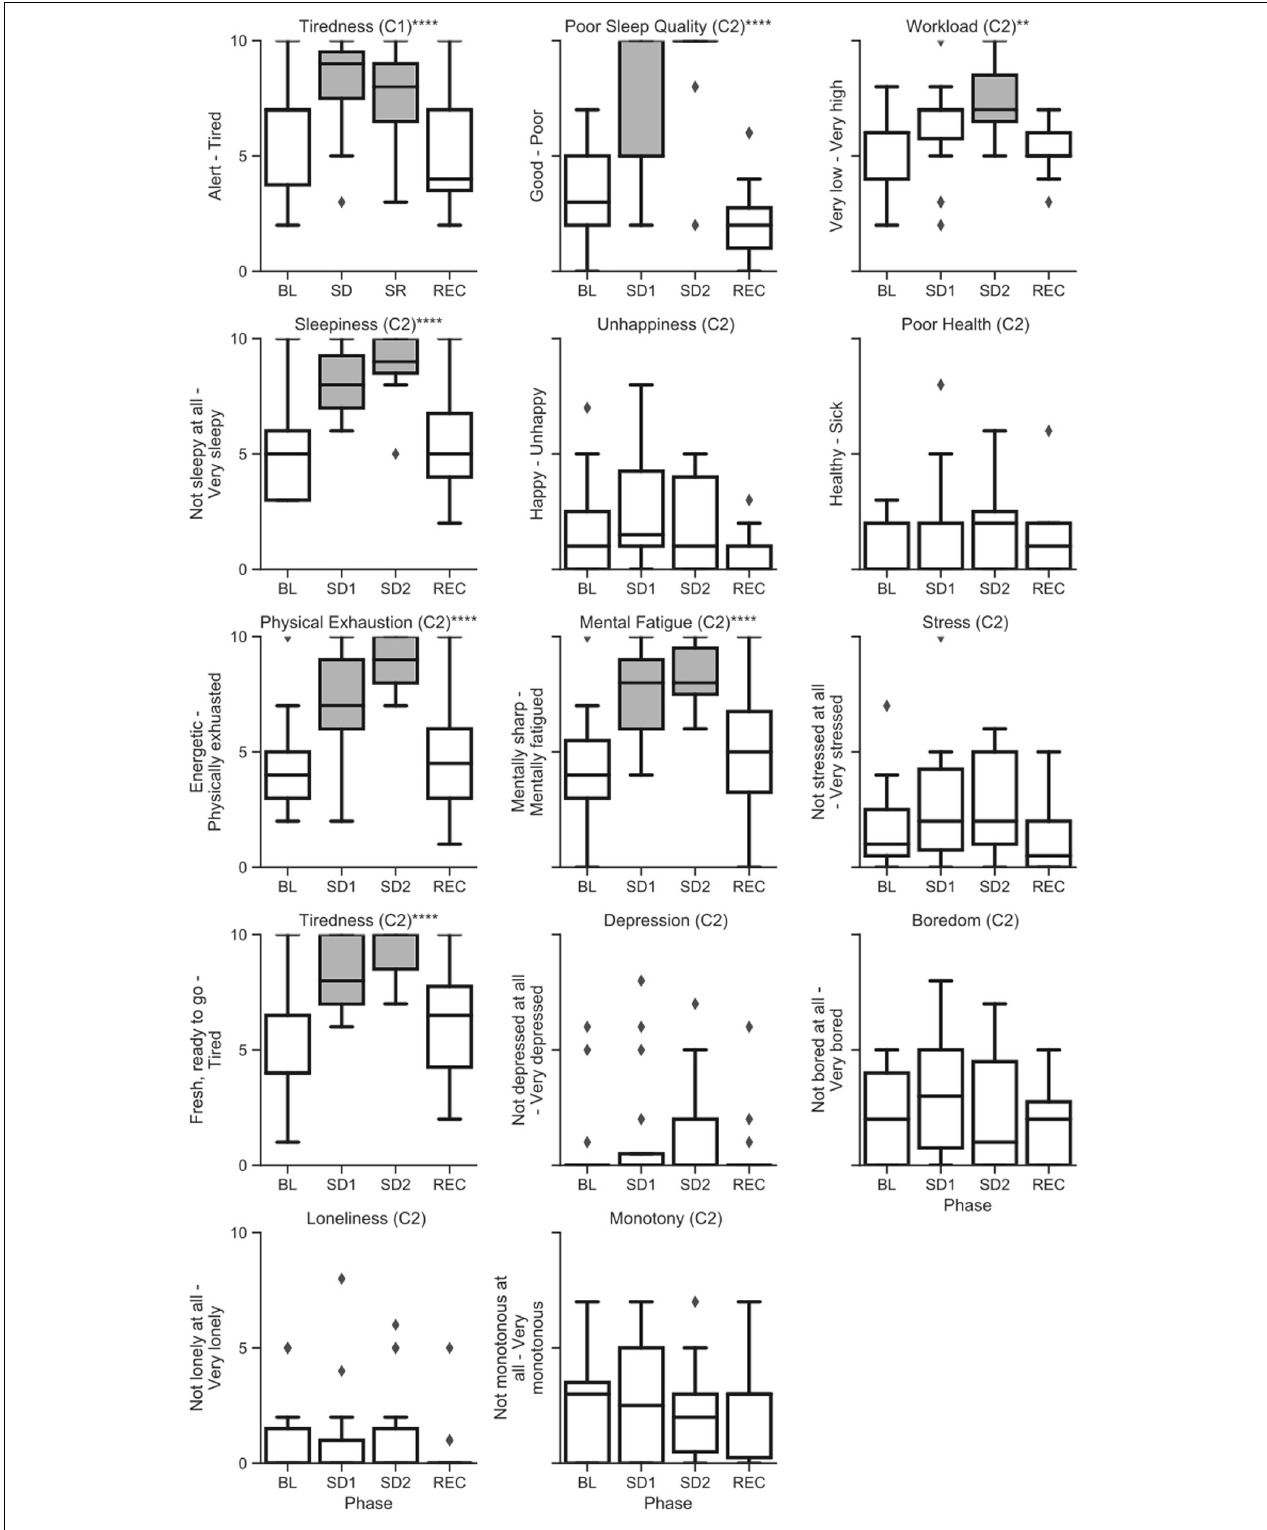
FIGURE 6 | Raw (untransformed) scores from the alertness and affect surveys across sleep deprivation phases in campaign 1 (C1) and campaign 2 (C2) of HERA. Asterisks refer to type-III significance levels of sleep deprivation as a main effect after adjusting for multiple testing with the false discovery rate (* p < 0.05; ** p < 0.01; *** p < 0.001; **** p < 0.0001). In plots with a significant omnibus effect, data shaded in gray were significantly different from baseline (BL) in a post hoc t -test.